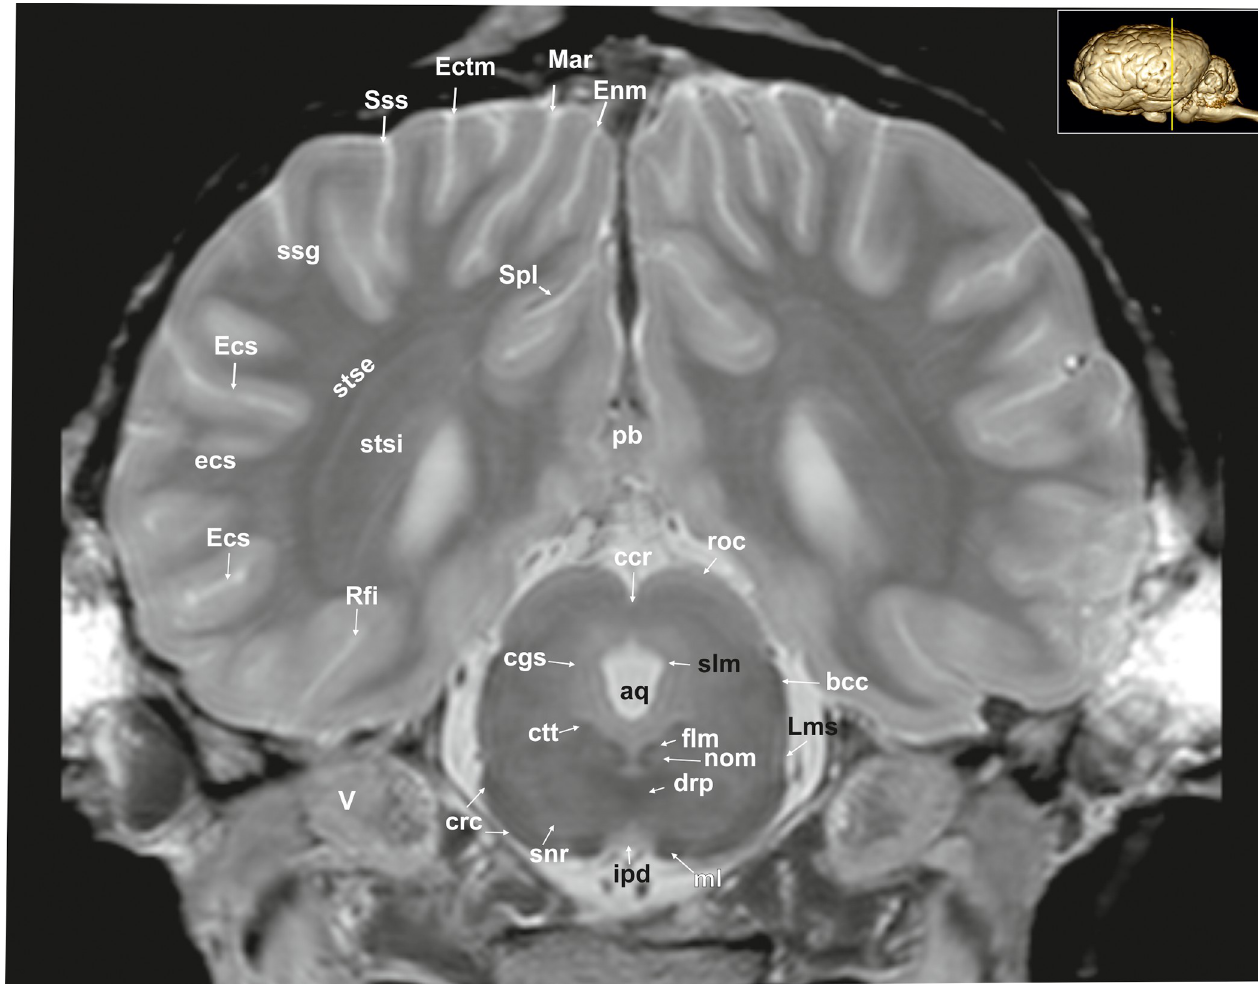
Fig 10. Transverse magnetic resonance image of the equine brain on the level of the rostral colliculi. aq: mesencephalic aqueduct, bcc: brachium of the caudal colliculus, ccr: commissure of the rostral colliculus, cgs: central grey substance, crc: cerebral crus, ctt: central tegmental tract, drp: decussation of the rostral cerebellar peduncles, Ecs: ectosylvian sulcus, Ectm: ectomarginal sulcus, Enm: endomarginal sulcus, flm: medial longitudinal fasciculus, ipd: interpeduncular nucleus, Lms: lateral mesencephalic sulcus, Mar: marginal sulcus, ml: medial lemniscus, nom: nucleus of the oculomotor nerve, pb: pineal body, Rfi: rhinal fissure, roc: rostral colliculus, snr: substantia nigra, Spl: splenial sulcus, stse: stratum sagittale externum, stsi: stratum sagittale internum, Sss: suprasylvian sulcus, V: trigeminal nerve.